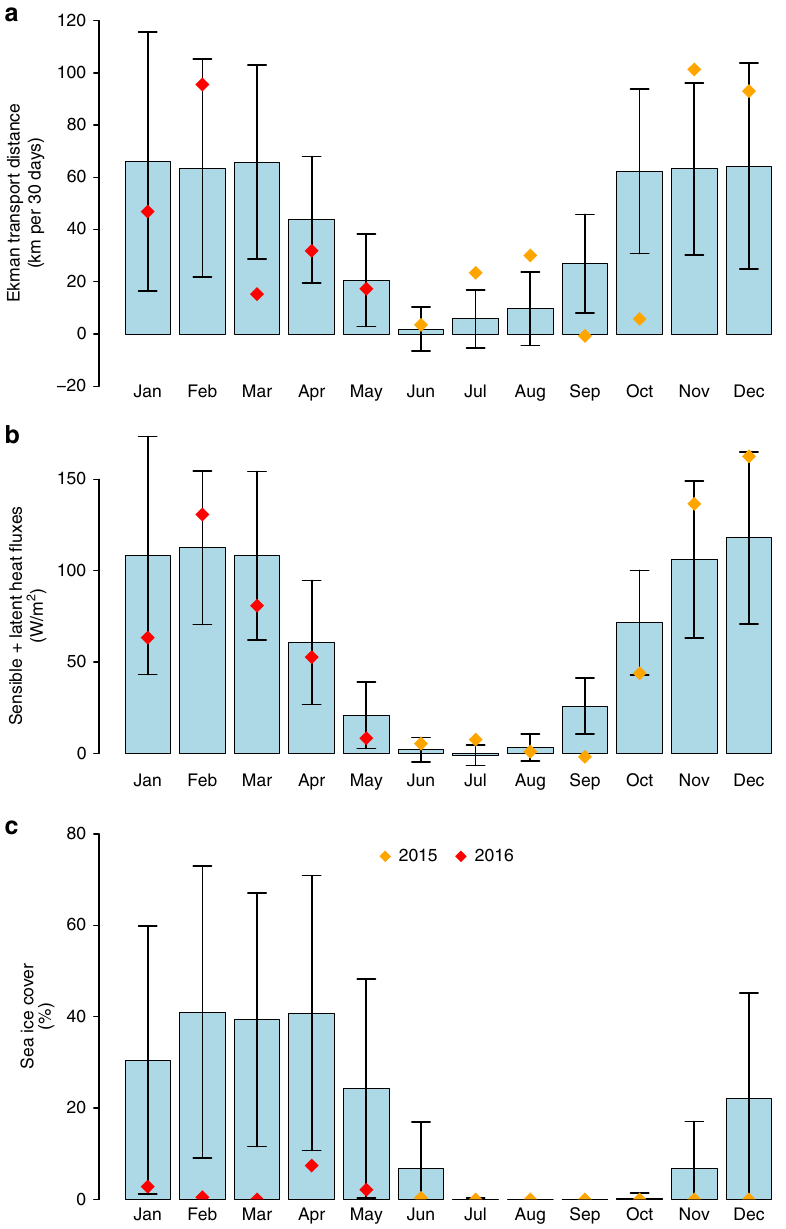
Fig. 5 Atmospheric and sea ice conditions in the western Iceland Sea. The panels show a monthly mean Ekman transport distances (positive direction toward the west, Ekman layer depth taken to be 50 m), b monthly mean total turbulent (sensible + latent) heat fl uxes, and c monthly mean sea ice concentrations in the region outlined in Fig. 1 over the ERA-Interim period (1979 – 2016). The black lines represent the standard deviations, and the red and yellow squares mark the corresponding values from the 2015 – 2016 deployment. Wind stress and turbulent heat fl uxes are averaged over the ice-free portions of the